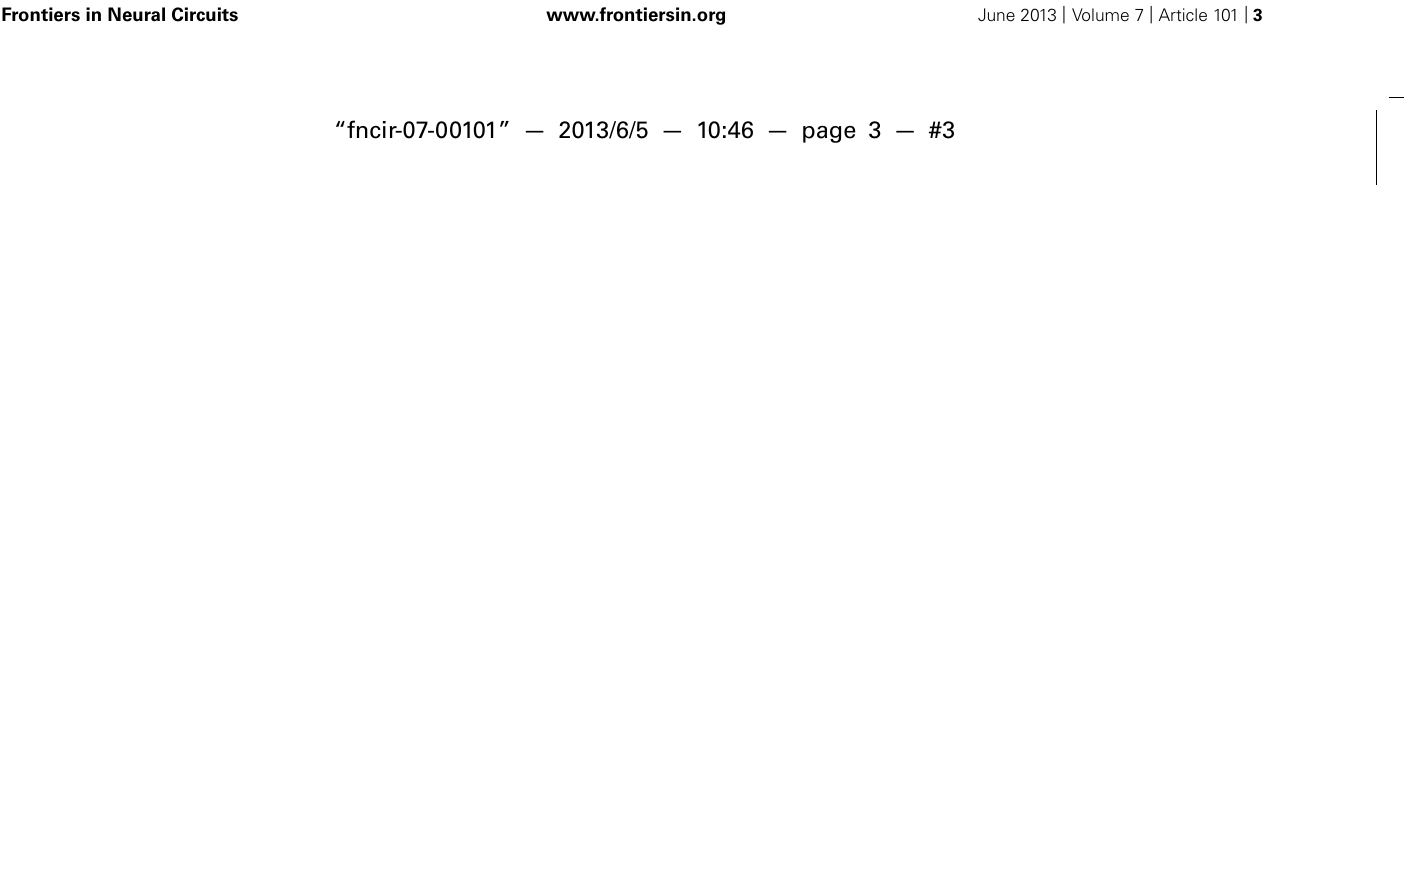
FIGURE 2 | How the optimal stimulus properties of sensory neurons may be constrained by network architecture. Panels (A,B) adapted with permission from DiMattina and Zhang (2008). (A) A simple neural network (left) and its responses to inputs x 1 , x 2 (right).The optimal stimulus for this network must lie on the boundary of any closed set of